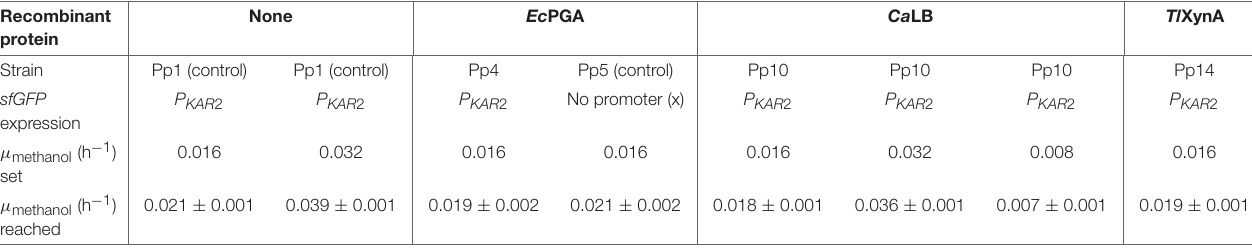
TABLE 1 | Overview of the fed-batch cultivations. Recombinant